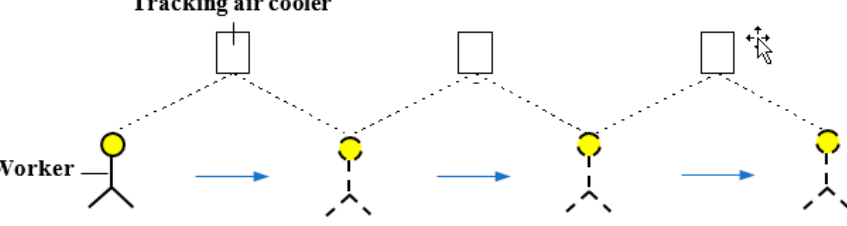
Figure 3. Schematic diagram of cooling process of the tracking air cooler.